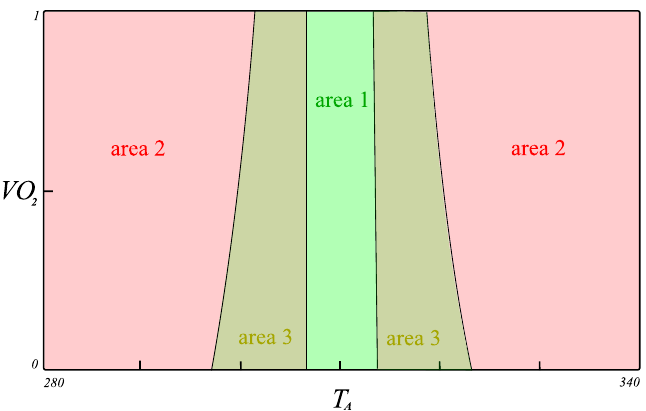
Figure 3. Transversal section through areas of stability of equilibria for parameter values given by Tables 2 and 3 and free parameters T A and V O 2 .